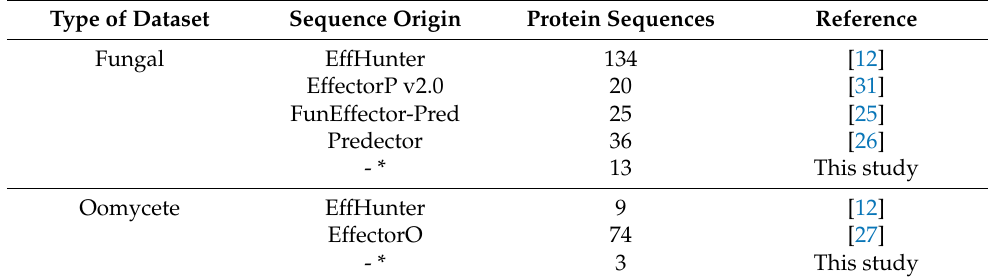
Table 1. List of positive datasets compiled in the present